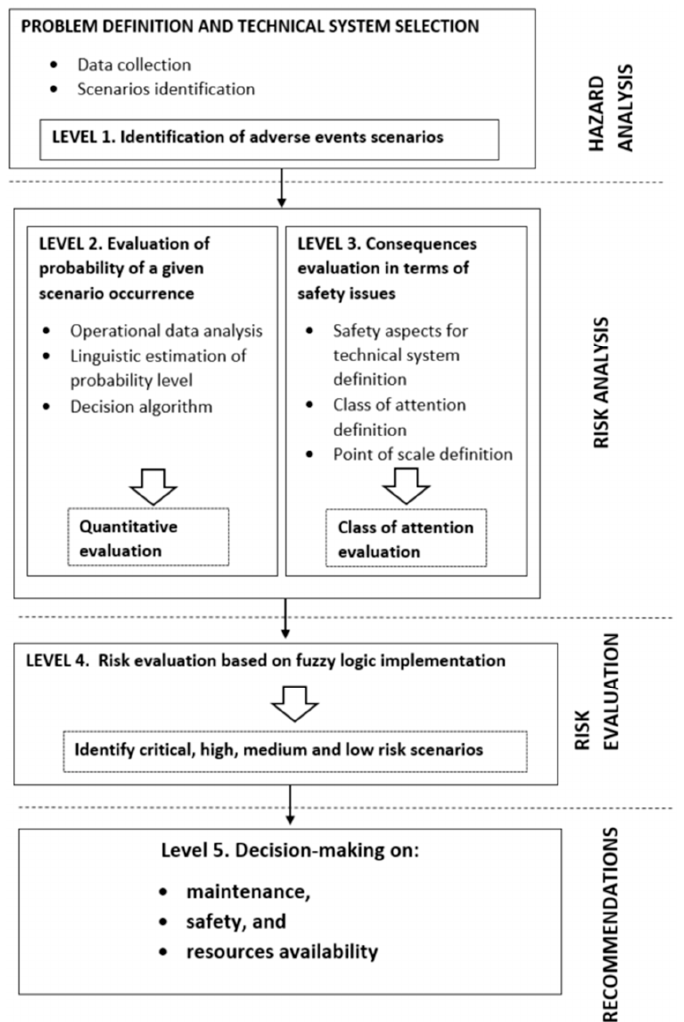
Figure 3. Fuzzy RBM methodology, as proposed in this study.